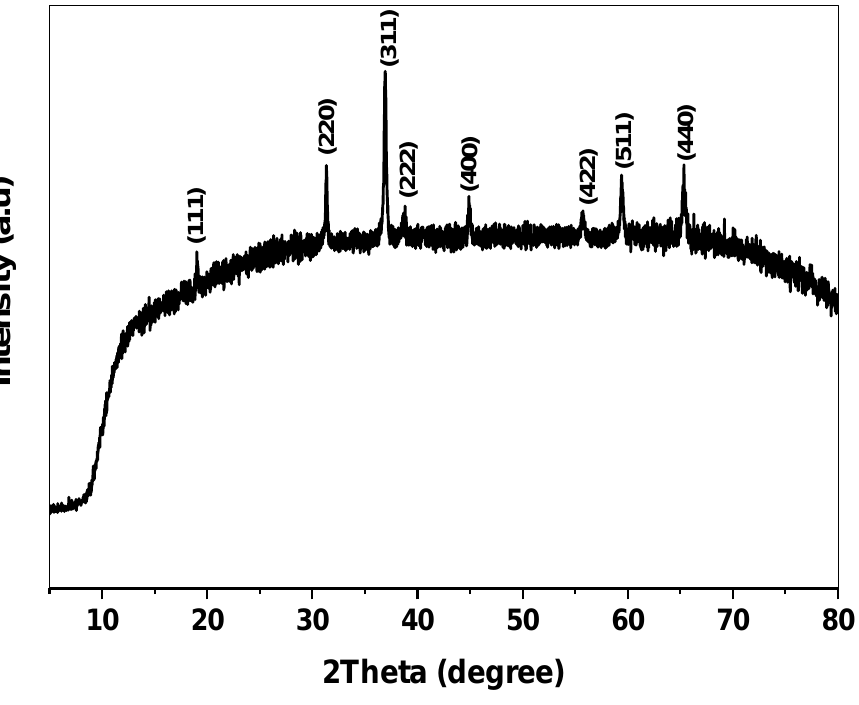
Figure 1. XRD pattern of the spinel Co 3 O 4 nanoparticles.